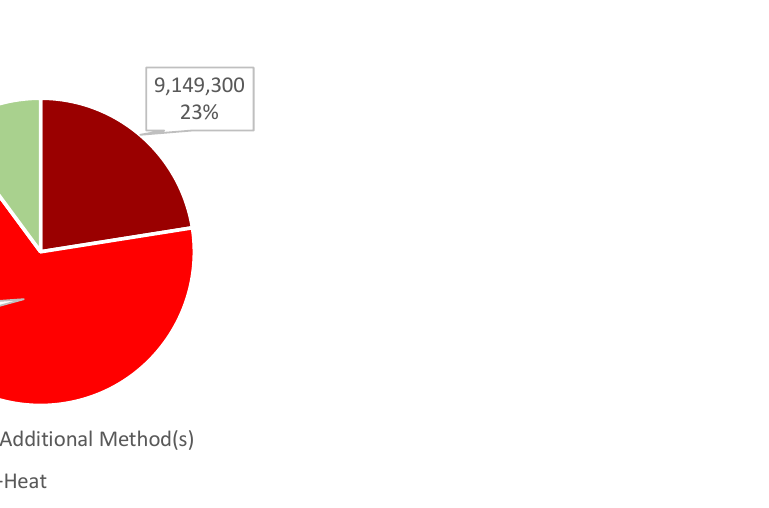
Figure 3. Number and percentage (%) of birds killed in HPAI depopulations in from January through August 2022.